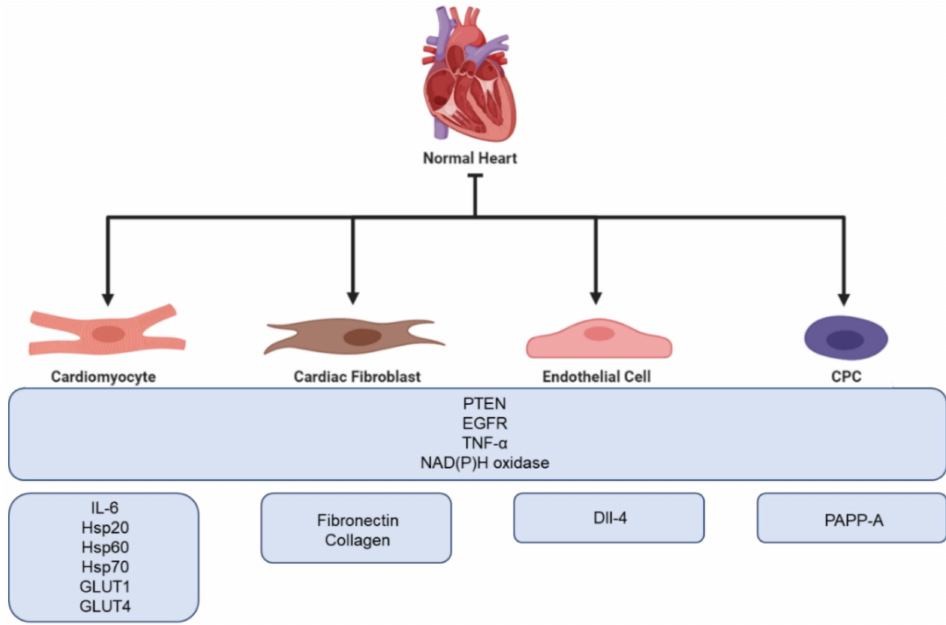
Figure 3. Overview of the cardioprotective proteins found in exosomes secreted from different cells of the